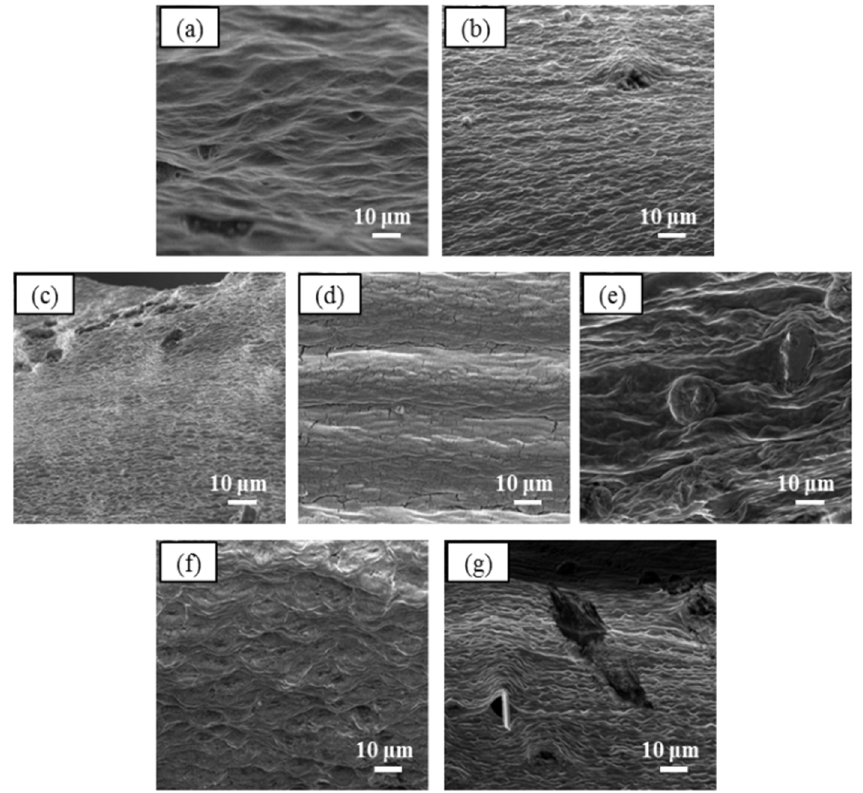
Figure 3. VPSEM cross sectional micrograph at 1000× magnification of ( a ) pure GG film, ( b ) GG-Carv 01, ( c ) GG-Carv 02, ( d ) GG-Carv 04, ( e ) GG-Carv 08, ( f ) GG-Carv 16 and ( g ) GG-Carv 32.